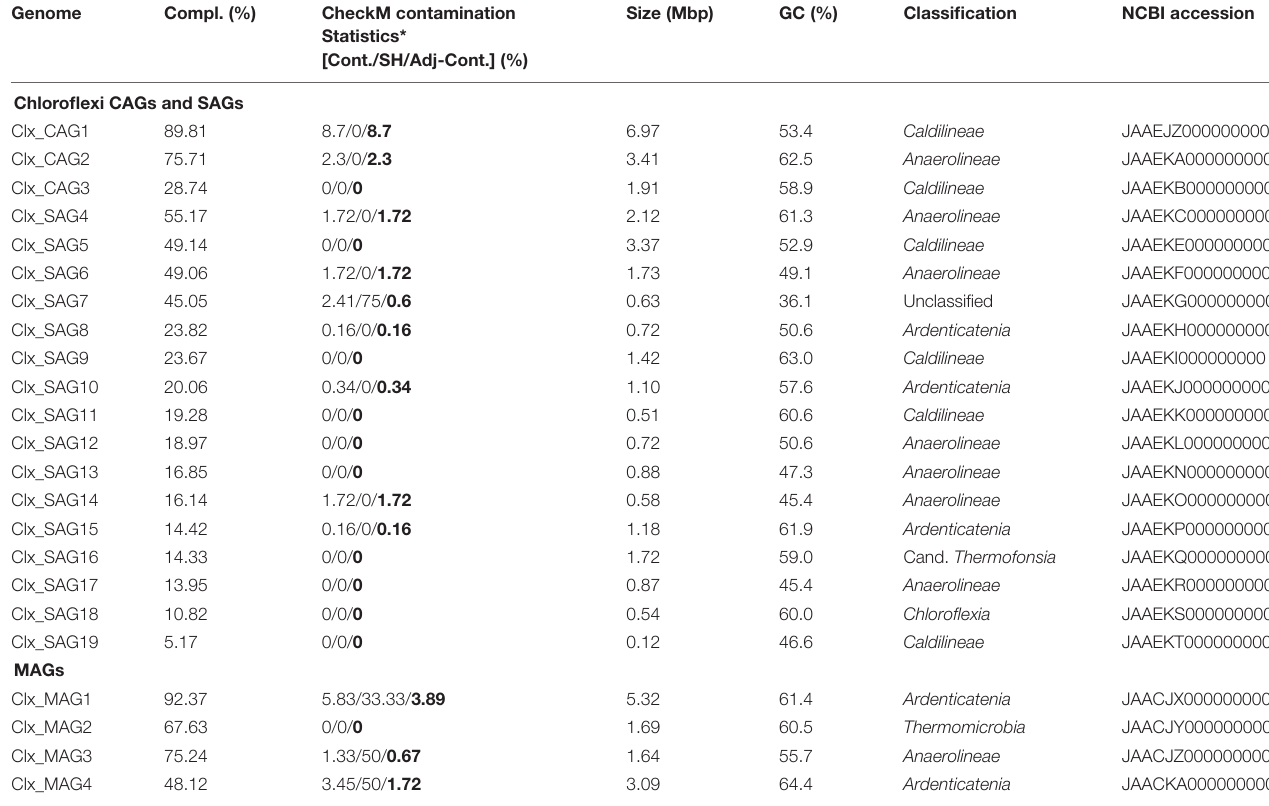
TABLE 1 | Overview of Chloroflexi co-assembled genomes (CAGs a ) and single amplified genomes (SAGs) obtained from targeted cell sorting combined with single-cell genomics and metagenome assembled genomes (MAGs) from the LEA2015 sample. Genome Compl.